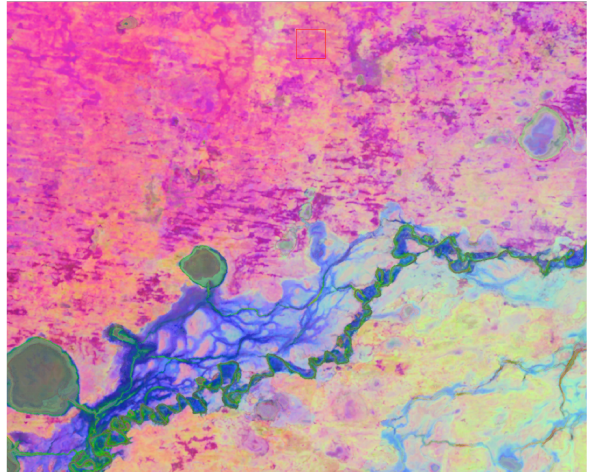
Figure 1. First three principle component of seasonal EVI standardized anomalies 1986-2011 on RGB showing contrasting vegetation response pattern over different dryland areas and floodplain units and